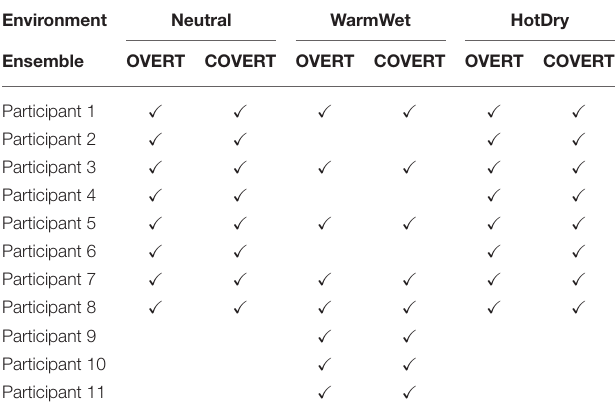
TABLE 1 | Trial completion